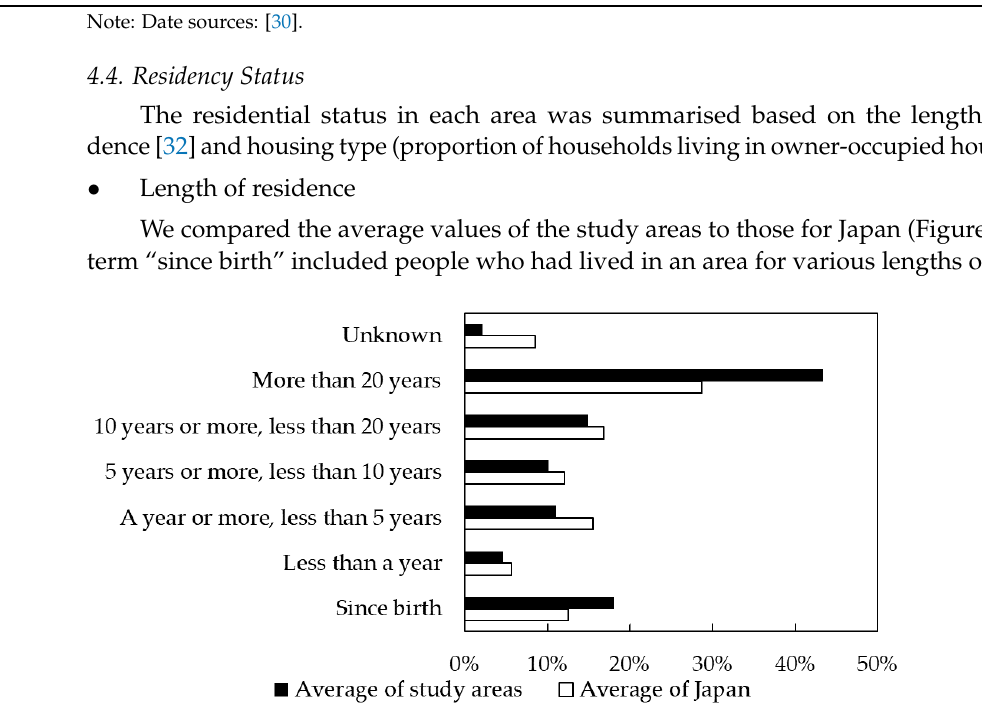
Figure 6. Length of residence . (Date sources: [32]).